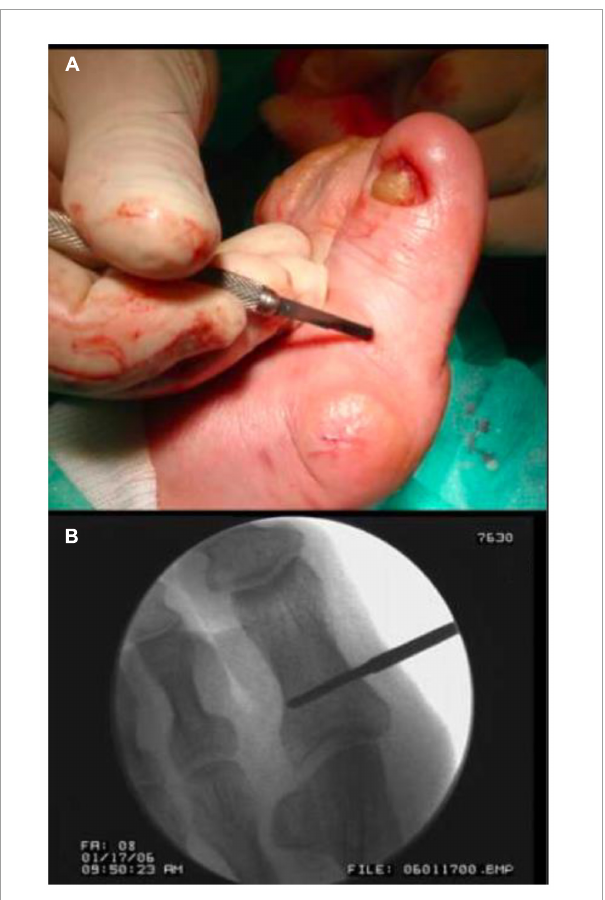
FIGURE6 Application of the surgical technique. Tenotomy of the big toe abductor tendon (A) and Akin’s osteotomy (B)